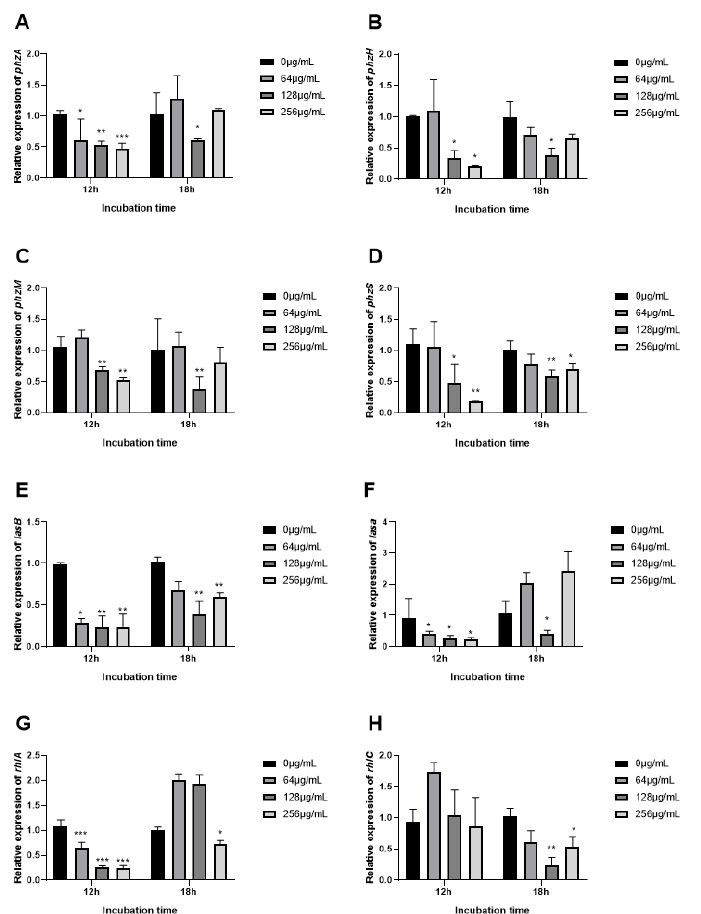
Figure 11. Effects of EGCG on virulence factors expression at 12 h and 18 h. (( A ) phzA; ( B ) phzH; ( C ) phzM; ( D ) phzS; ( E ) LasB; ( F ) LasA; ( G ) rhlA; ( H ) rhlC). (All data are representative of three independent experiments performed in triplicate and expressed as the mean ± SD values in each bar. * p < 0.05; ** p < 0.01; *** p < 0.001).